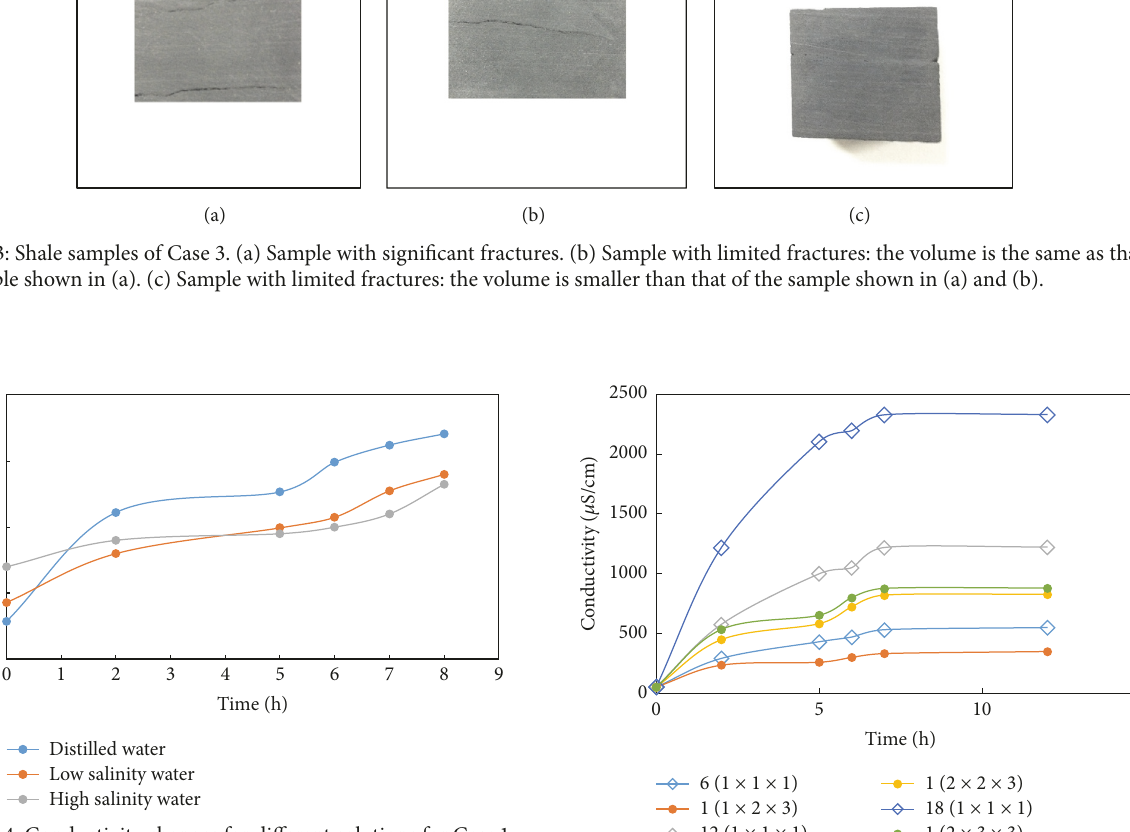
Figure 4: Conductivity changes for different solutions for Case 1.